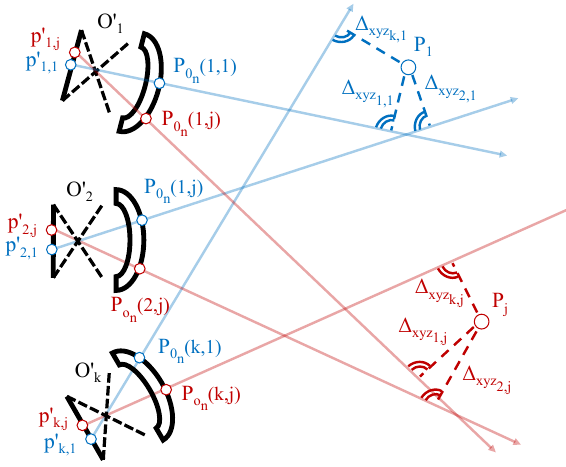
Figure 2. Visualization of the error function in object space. The is calculated as a 3D orthogonal line-point distance ∆ xyz k,j vector that is subject to minimization by means of least